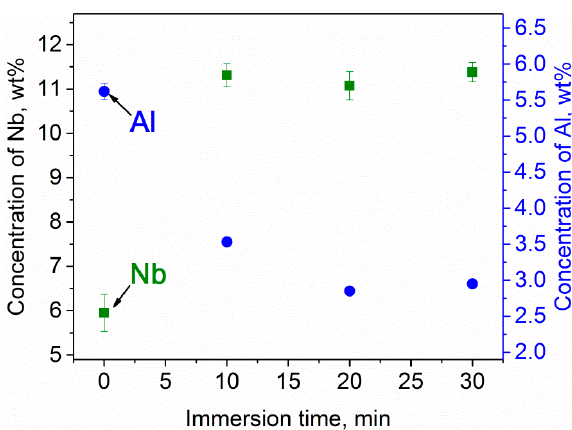
Figure 7. Concentration of Nb and Al in the surface layer of Ti-6Al-7Nb before and after dealloying (porous layer) in liquid Mg at 1150 K for different times. Note: The size of the error bars in the case of Al is below that of the round symbols; the error bars indicate standard deviation.